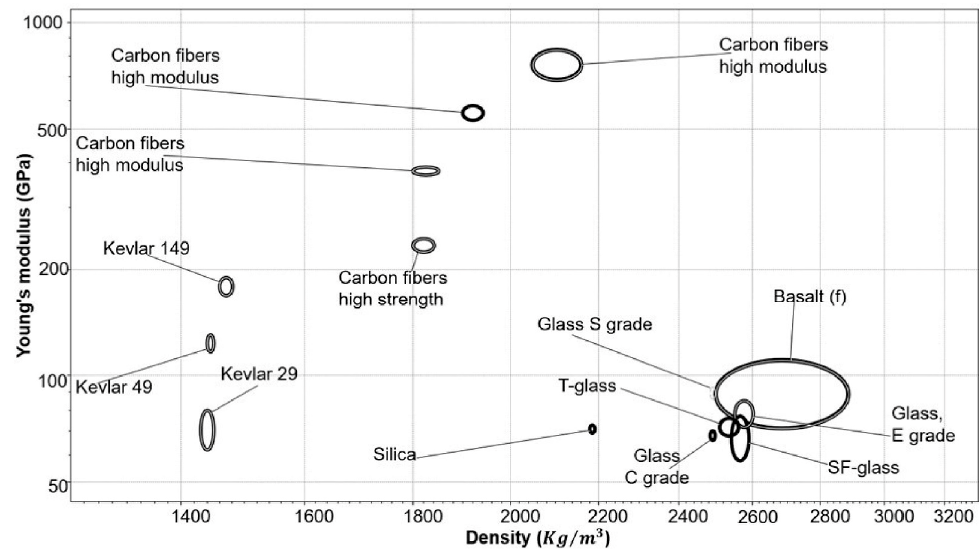
Figure 4. Young’s Modulus vs. Density (Generated by CES EduPack, 2015).